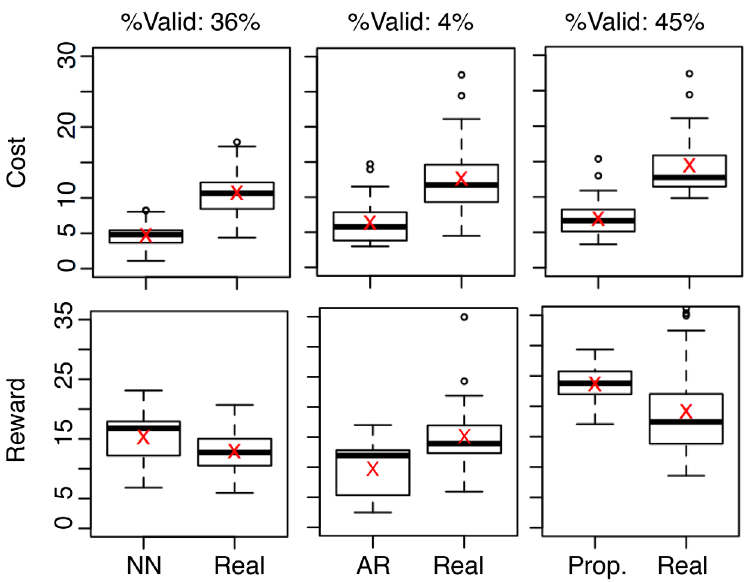
Fig 8. Cost distribution of valid answers using different methods. The cost distribution of each method is contrasted with that of the same set of samples in the real case. The mean values are marked using red